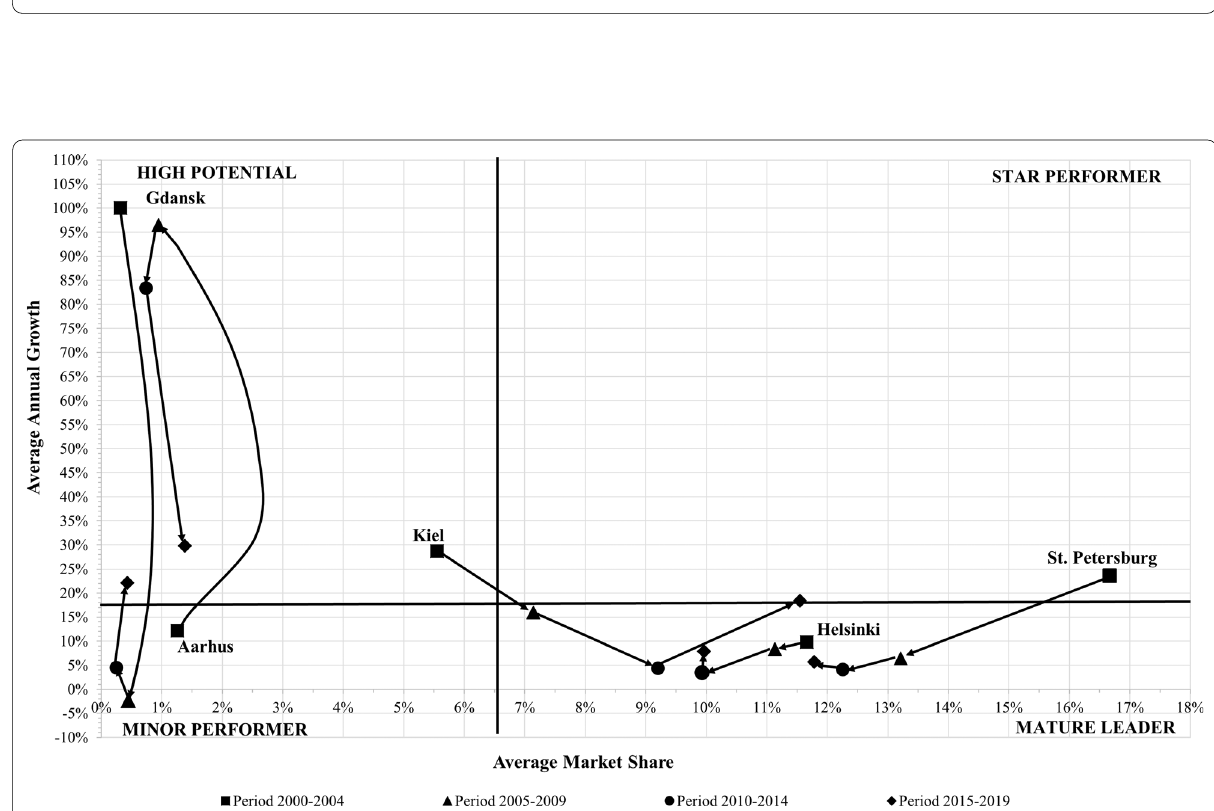
Fig. 5 Dynamic portfolio analysis of ports of Copenhagen, Oslo, Rønne, Rostock and Tallinn during the 2000–2019 period. Source : Author’s elaboration